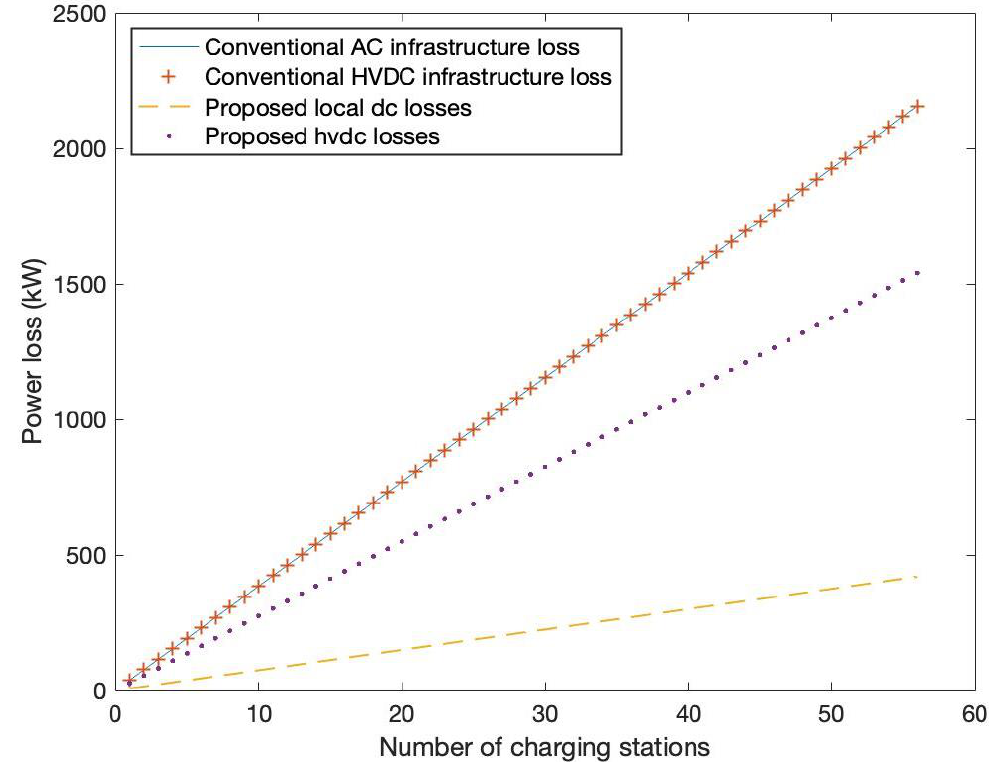
Figure 5. Power loss comparison for grid-tied DC fast chargers, in-practice HVDC systems, and proposed DC network.